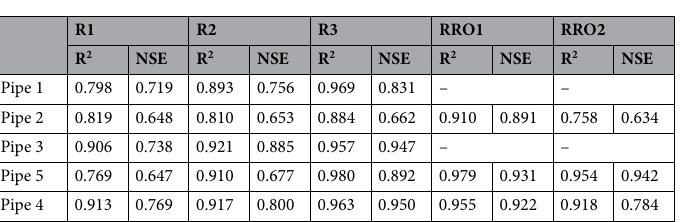
Table 2. Results of the correlation